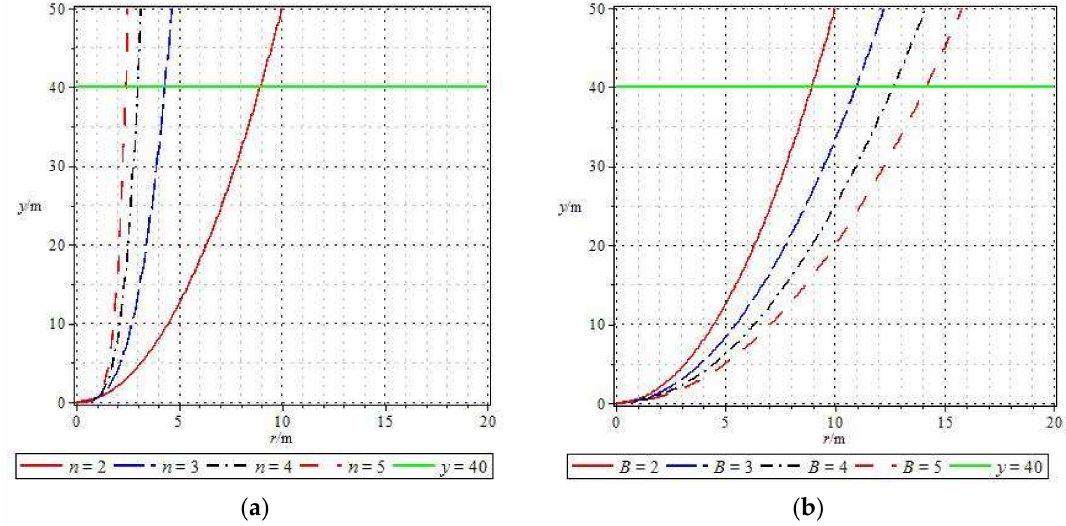
Figure 7. The change laws of movement boundary with n and B ( r 0 = 0). ( a ) B = 2; ( b ) n =